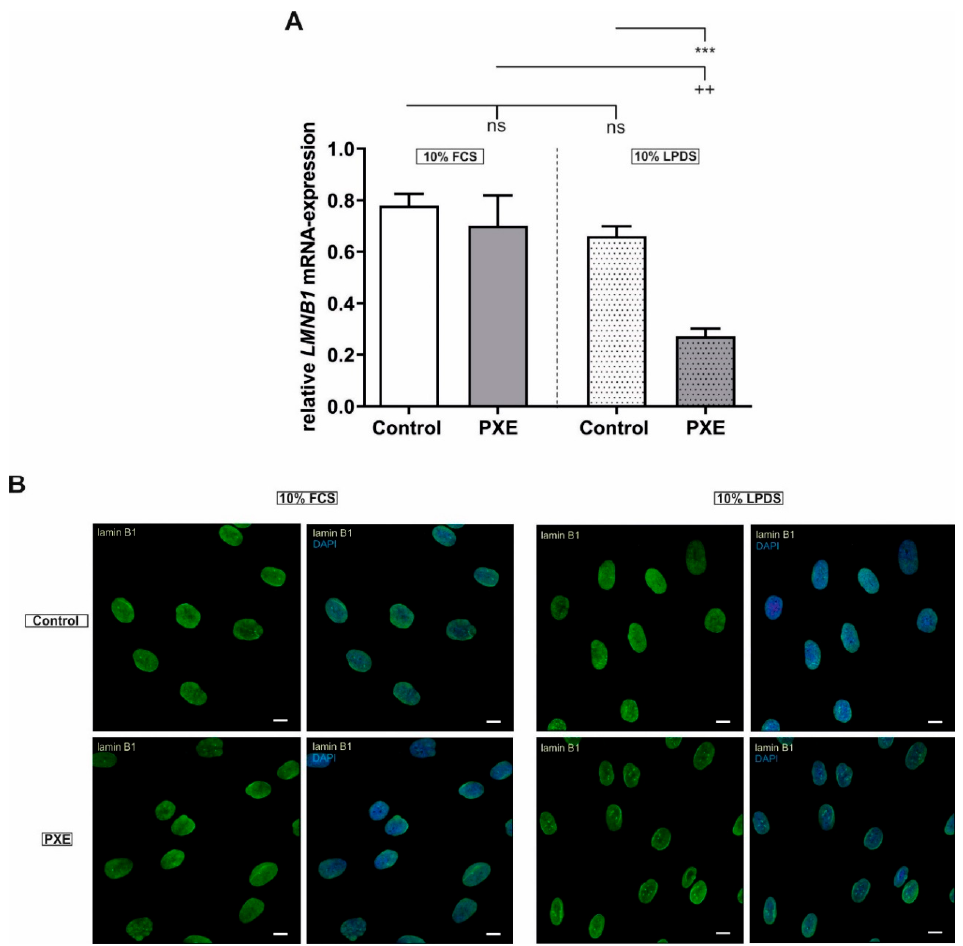
Figure 2. Relative LMNB1 mRNA-expression and immunofluorescence microscopy of lamin B1 for PXE fibroblasts and NHDF ( A ) Relative LMNB1 mRNA-expression of PXE fibroblasts (gray, n = 3) and NHDF (white, n = 3) after 24 h cultivation in 10% FCS or 10% LPDS. Data are shown as mean ± SEM. Control/PXE: *** p ≤ 0.001; ns p > 0.05. 10% FCS/ 10% LPDS: ++ p ≤ 0.01; ns p > 0.05. ( B ) Immunofluorescence microscopy of lamin B1 (green) for PXE fibroblasts ( n = 3) and NHDF ( n = 3) after 72 h cultivation in 10% FCS or 10% LPDS. Cell nuclei were counterstained with DAPI (blue). Representative images are shown. Scale bar: 10 µ